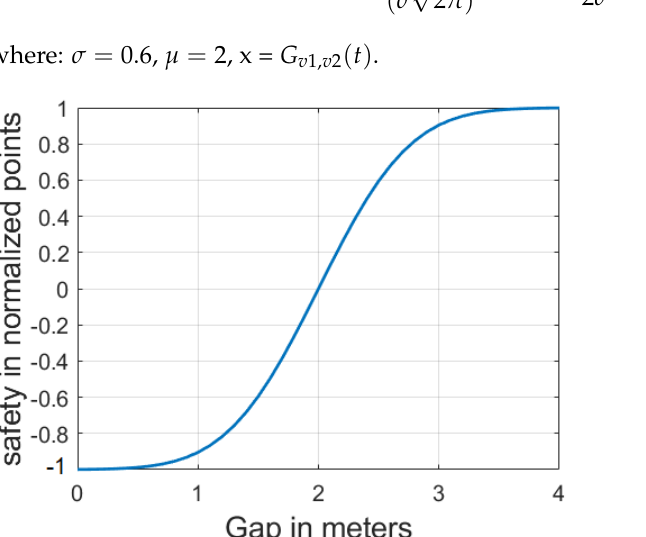
Figure 3. FV’s safety function represented by safety in the form of scored points and the headway or gap between vehicles in